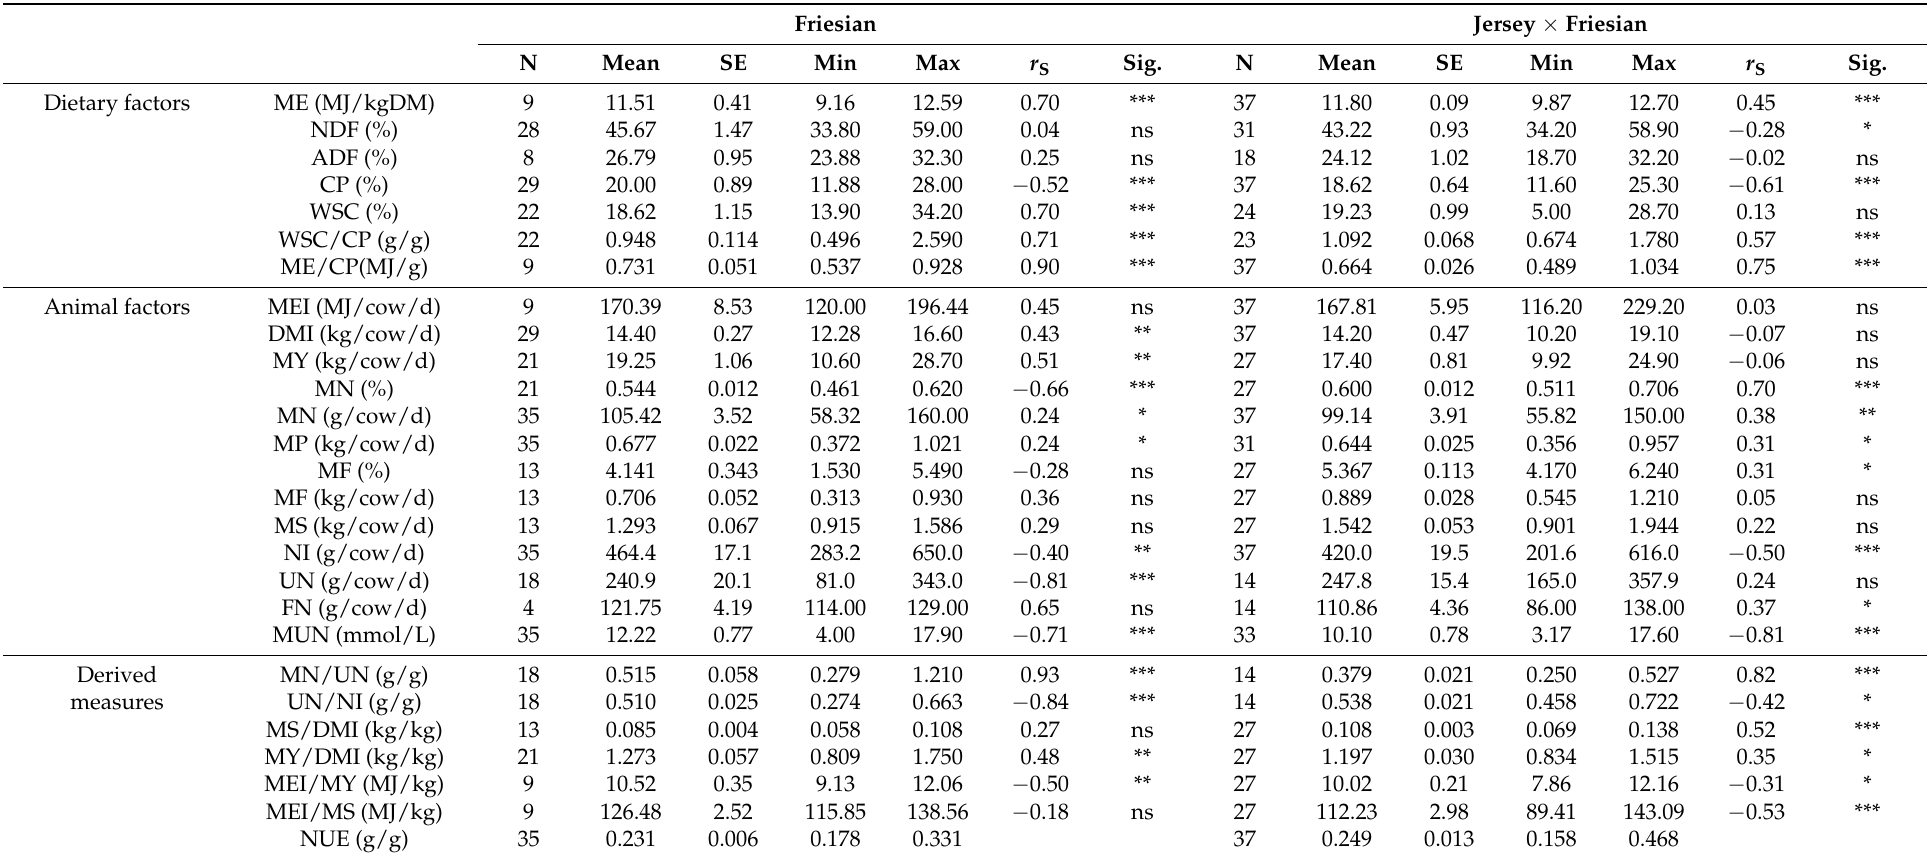
Table 3. Summary of parameters for ryegrass-fed Friesian and Jersey × Friesian dairy cows used in this analysis. N = the number treatment means used in the calculation of the summary statistics for each